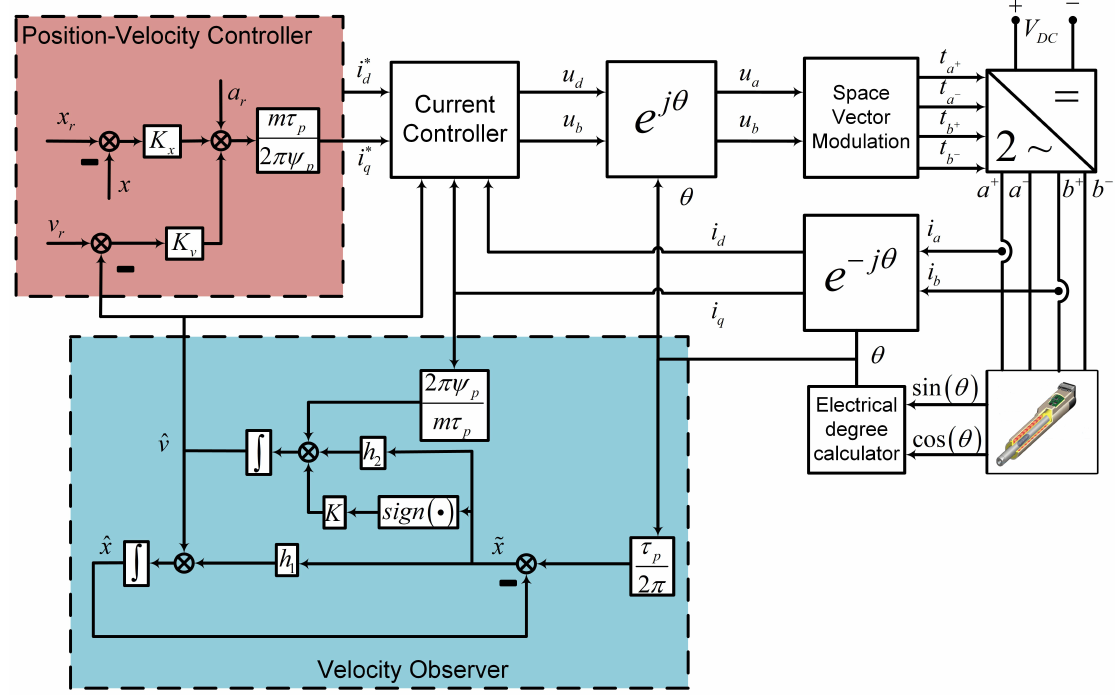
Figure 3. The proposed control scheme of polysolenoid linear motor.